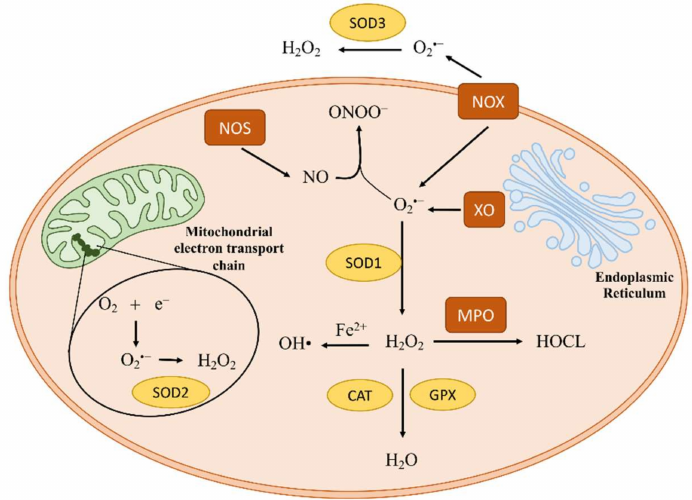
Figure 1. Endogenous sources of oxidants. Cellular ROS and RNS can be generated from different metabolic reactions, including mitochondrial electron transport and inflammation processes. Under physiological conditions, 0.2–2% of the electrons in the mitochondrial electron transport escape from the transport and interact with oxygen to produce superoxide (O 2 •− ) or hydrogen peroxide (H 2 O 2 ). Moreover, inflammatory processes contribute to the increase in ROS/RNS by the activation of numerous pro-oxidant enzymatic systems, such as NADPH oxidase (NOX), xanthine oxidase (XO), myeloperoxidase (MPO), and nitric oxide synthase (NOS). However, the presence of antioxidant enzymes, including superoxide dismutase (SOD), catalase (CAT), and glutathione peroxidase (GPX), contributes to maintaining the biological redox homeostasis.